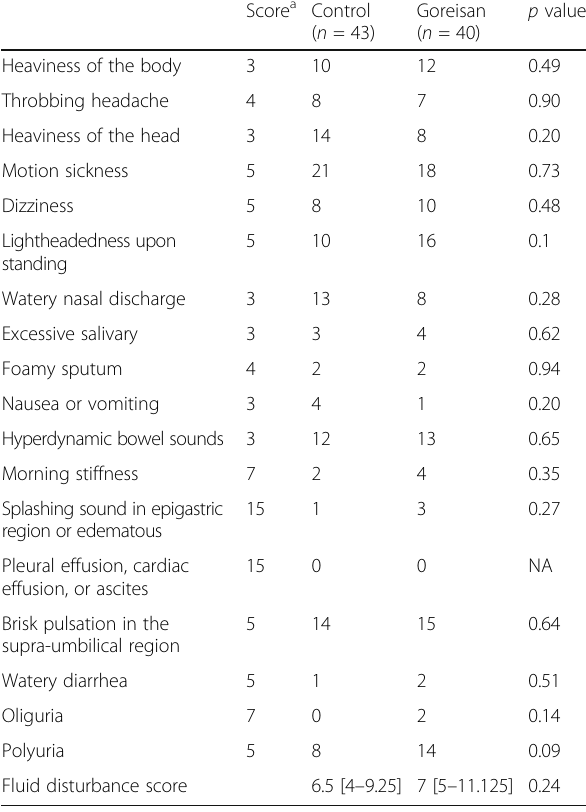
Table 3 Fluid disturbance